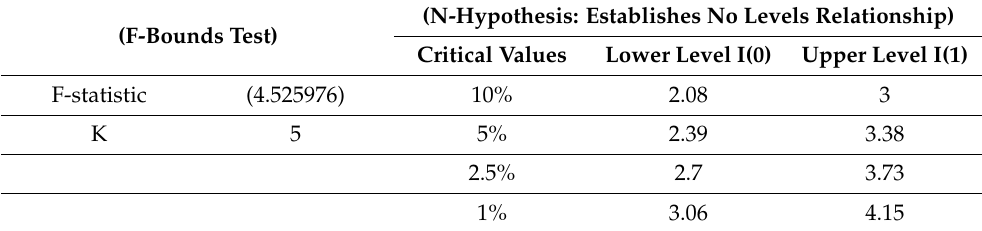
Table 6. Bounds tests to cointegration.